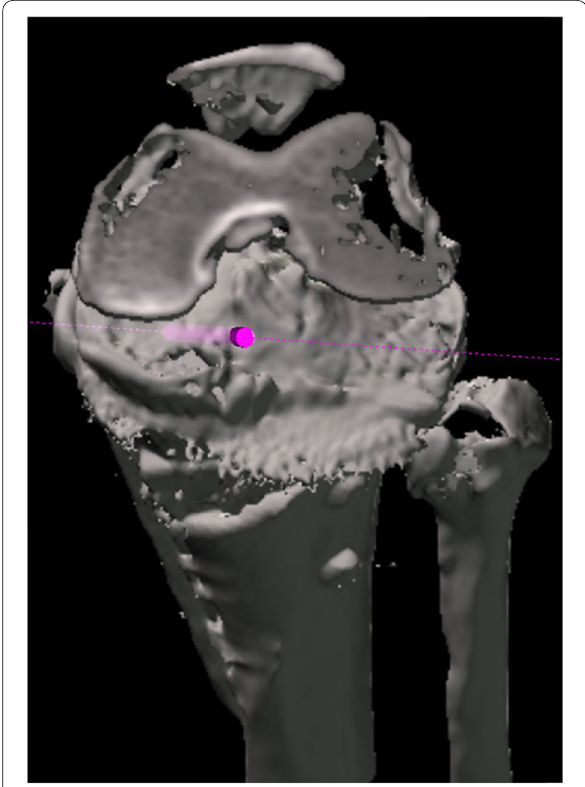
Fig. 1 The tibial tunnel was made in the centre of the anatomical attachment area of the medial meniscus posterior root, which contacted three sides: the anterior border of the posterior cruciate ligament tibial attachment, lateral margin of the medial tibial plateau, and retro-eminence ridge